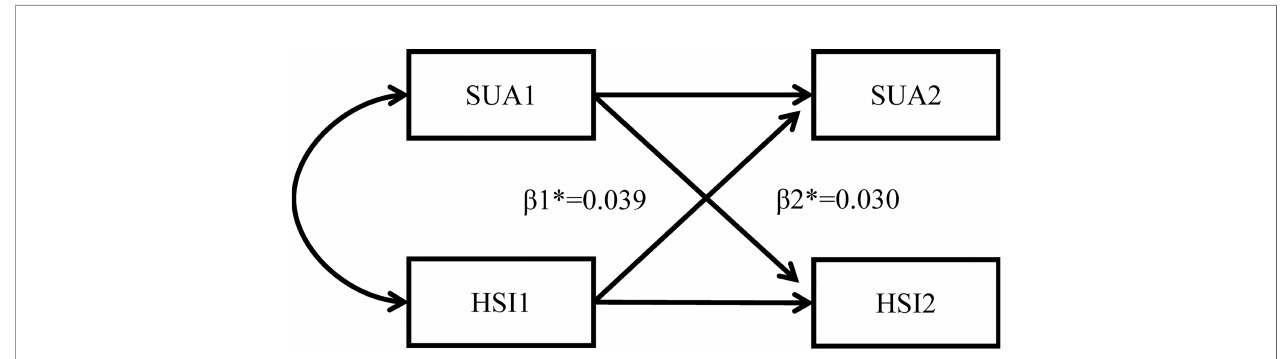
FIGURE 2 | Cross-lagged path analysis pattern diagram. SUA, serum uric acid; HSI, hepatic steatosis index *: b 1, baseline hyperuricemia to subsequent MAFLD; b 2, baseline MAFLD to subsequent hyperuricemia; MAFLD, metabolic dysfunction-associated fatty liver